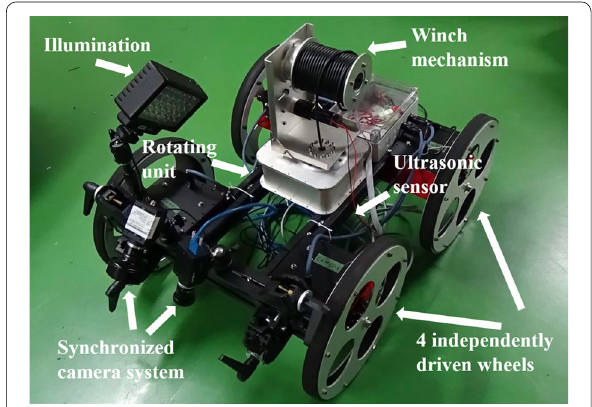
Fig. 9 Overview of the prototype model robot for